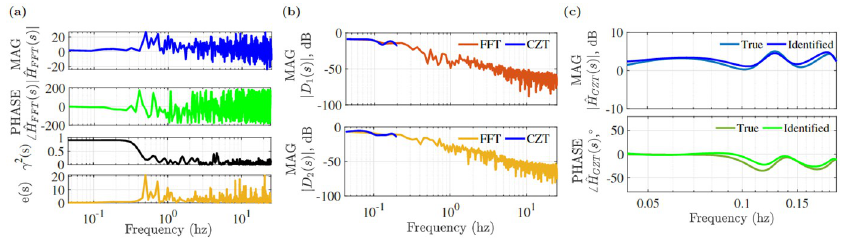
Fig 6. (a) Magnitude j ^ H ð s Þj in dB, phase < ^ H ð s Þ in ˚, coherence γ 2 ( s ) and tracking error e ( s ), (b) FFT and FFT FFT CZT magnitude plots of D 1 ( s ) and D 2 ( s ), (c) magnitude and phase of ^ H ð s Þ . CZT https://doi.org/10.1371/journal.pone.0278167.g006 X axis stimulus movement. Tracking sections are shaded in gray. After obtaining the tracking sections of X coordinates we concatenated them and performed frequency domain transfor- mation. For this trajectory, the concatenated trajectories of stimulus D ( t ) and bee D ( t ), and 1 2 their magnitude | D ( s )|, dB and phase ∠ D ( s ) converted by the FFT transform are shown in Fig i i 5c. Now we want to see the transfer function of the system by considering stimulus D ( s ) as 1